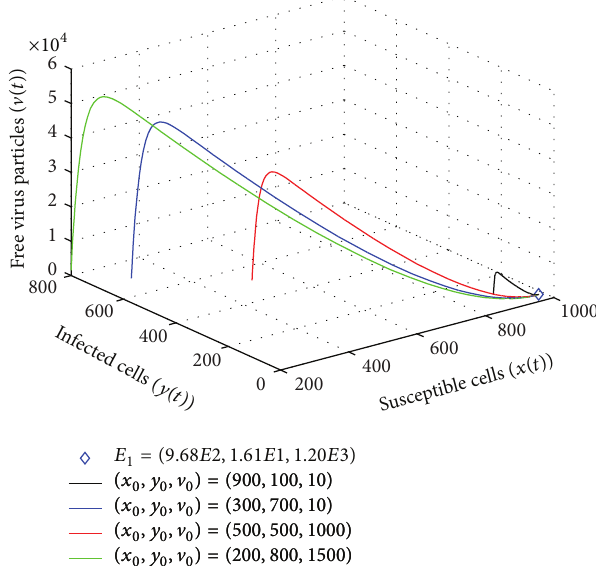
Figure 1: Phase diagram of system (2) under different initial conditions. Here 𝑓( V ) = 𝛽/(1 + 𝑏 V ) and 𝑟 = 10.0 , 𝑚 = 0.01 , 𝛽 = 3.60 × 10 −6 , 𝑎 = 0.02 , 𝑏 = 0.01 , 𝑘 = 50 , and 𝑢 = 0.67